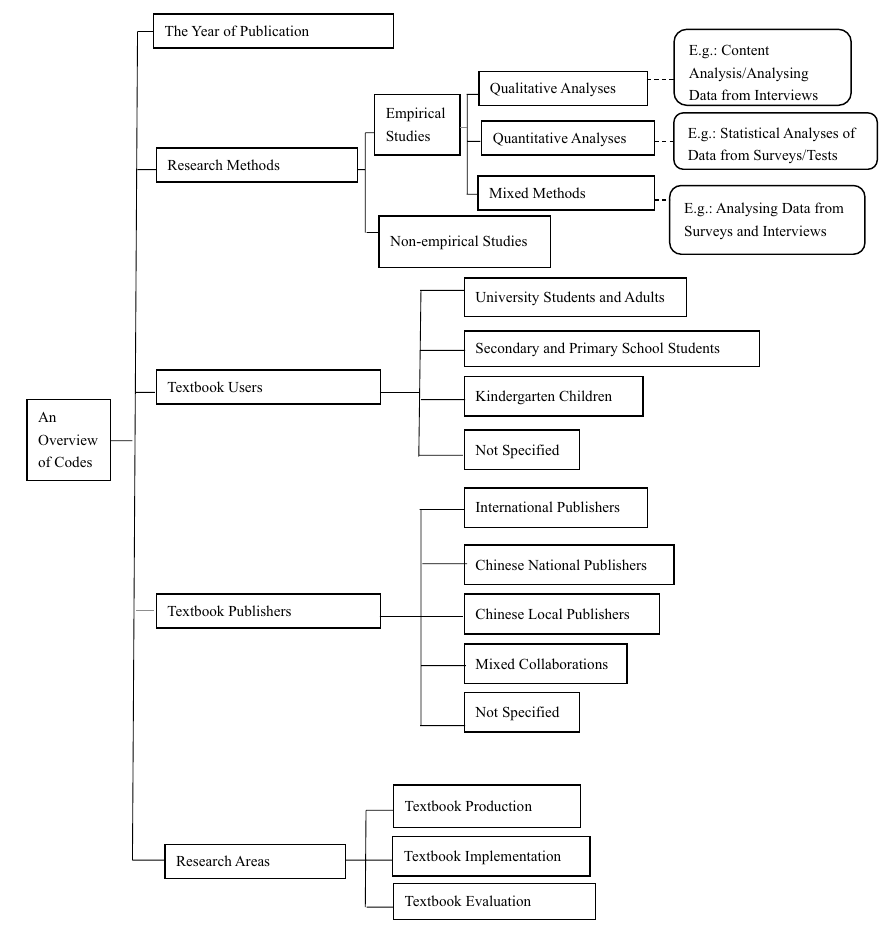
Fig. 2 An overview of the coding